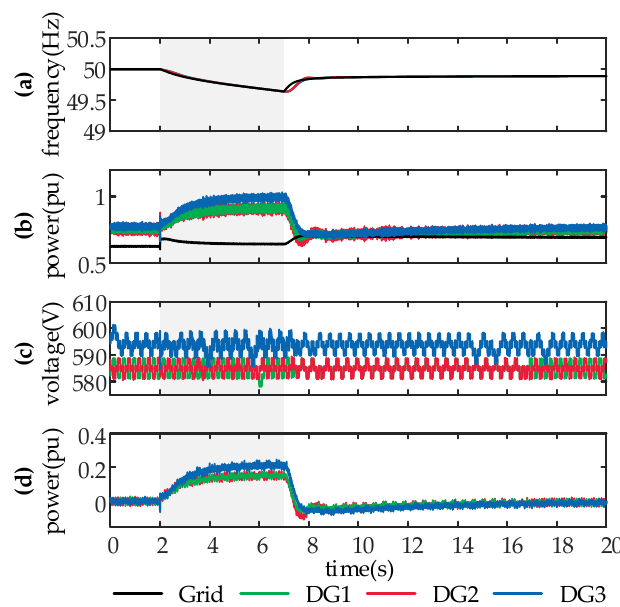
Figure 9. Responses to sudden load variation when the proposed PV systems are applied as DG1– DG3: ( a ) Frequency response; ( b ) output active power; ( c ) dc link voltage of the inverter; ( d ) exchanged power between the ES unit and dc link.